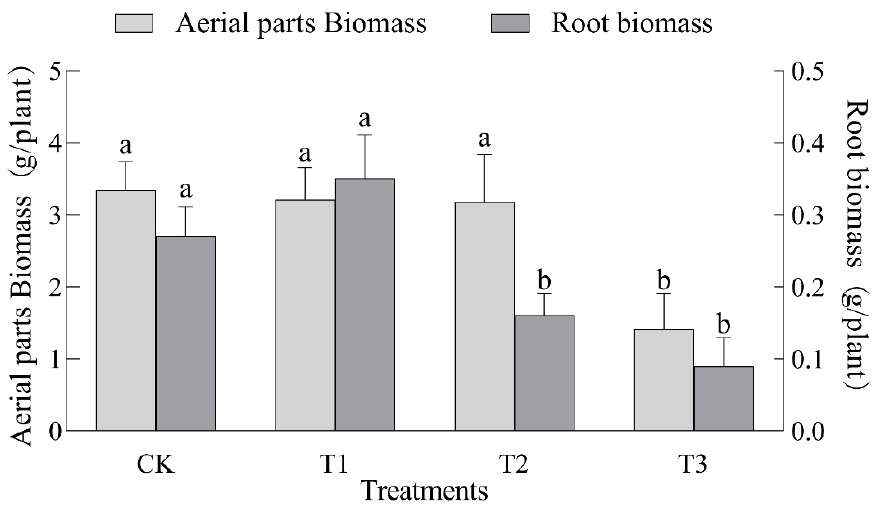
Figure 2. Effects of different treatments on fresh weight biomass of aerial parts and roots of tobacco. Note: Different lowercase letters indicate that the differences between treatments reached a significant level ( p < 0.05).